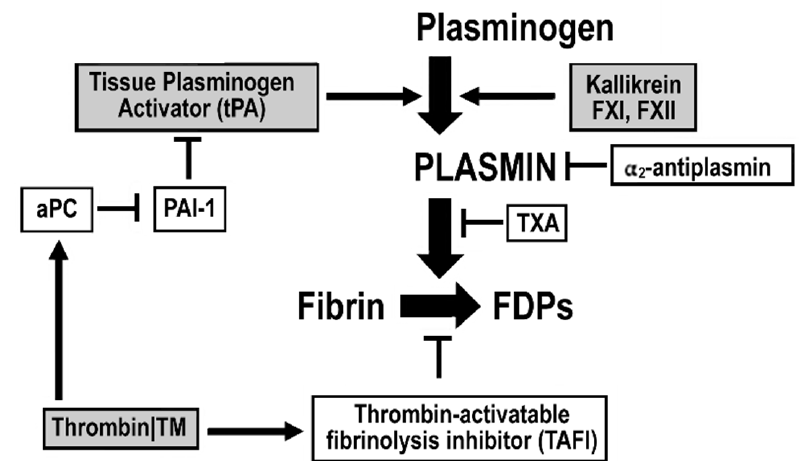
Figure 3. Pathways of plasminogen activation and inhibition. Plasminogen is synthesized by and released from the liver. To be activated to plasmin, plasminogen initially binds to lysine residues exposed on fibrin. The generation of plasmin from its precursor, plasminogen is achieved by the plasminogen activators, tissue-type type plasminogen activator (tPA), and urokinase (not depicted). Protien C, once activated by thrombin bound to thrombomodulin blocks PAI-1, the major inhibitor of tPA; therefore thrombin, through activated protein C, can promote fibrinolysis. However, thrombin-thrombimodulin interactions can also inhibit fibrinolysis through activation of TAFI (thrombin-activatable fibrinolysis inhibitor). Plasmin once formed can also cleave plasma prekallikrein (Fletcher factor) and Hageman factor (FXII) and in turn plasminogen can be activated to plasmin by these proteases. Furthermore, plasmin, can activate the complement factors, C5 and C3, while on the other hand, it can itself be inhibited by the C1-inhibitor, thereby providing a natural means to regulate this process. Excessive plasmin formation can result in hyperfibrinolysis, which increases the risk of bleeding. Tranexamic acid (TXA) blocks lysine-dependent interactions and therefore inhibits binding of plasminogen to and transfusion requirements. Plasminogen receptors located on the surface of immune cells also contain C-terminal lysine the surface of fibrin and misfolded proteins. Plasmin also activates other substrates with pro-inflammatory potential including TGF- β , a neurotrophic agent brain-derived neurotropic factor, and other proteases like the matrix metalloproteinases. HF is a highly lethal, typically fulminant coagulopathy associated with a mortality as high as 75 percent in adults [65] and 100 percent in pediatric patients [67]. This